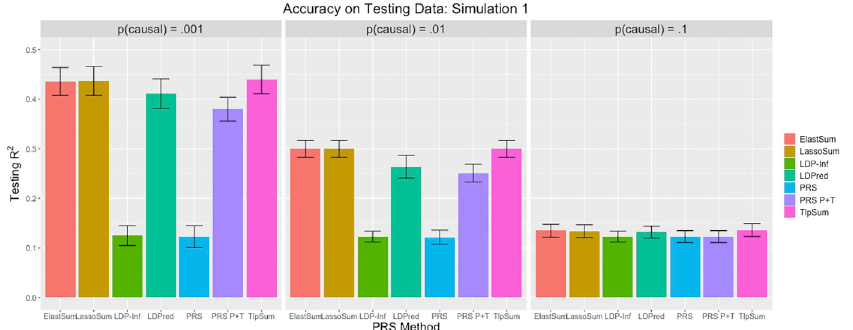
Fig 1. Prediction r 2 values for simulation 1. Error bars represent standard deviation for the r 2 value across 20 replications.